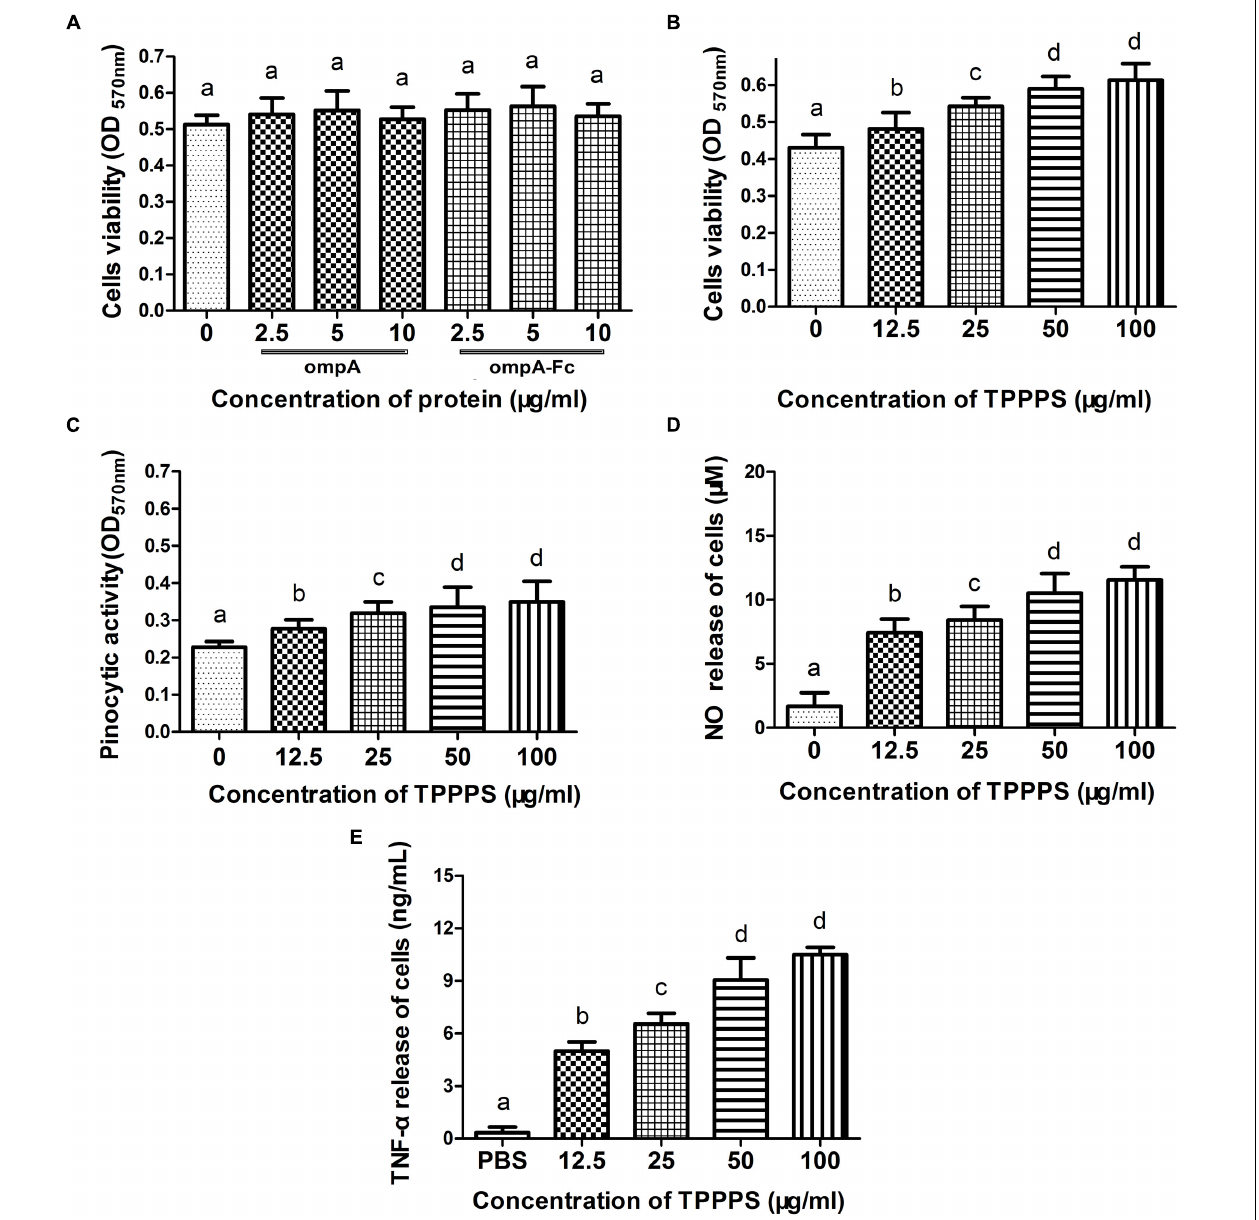
FIGURE 2 | Influences of the linked Fc or Taishan Pinus massoniana pollen polysaccharide (TPPPS) on macrophage activity. Peritoneal macrophages were cultured with the various concentrations of ompA–Fc (2.5, 5, and 10 µ g/mL), ompA (2.5, 5, and 10 µ g/mL), TPPPS (12.5, 25, 50, and 100 µ g/mL), and PBS for 24 h. The activity of peritoneal macrophages was determined by MTT assay (A,B) . The neutral red uptake (C) , NO (D) , and TNF- α (E) production of peritoneal macrophages were detected as previously described. All values represent the means ± SD of triplicate experiments. Different lowercase letters above the columns indicate significant differences between the different groups ( P <